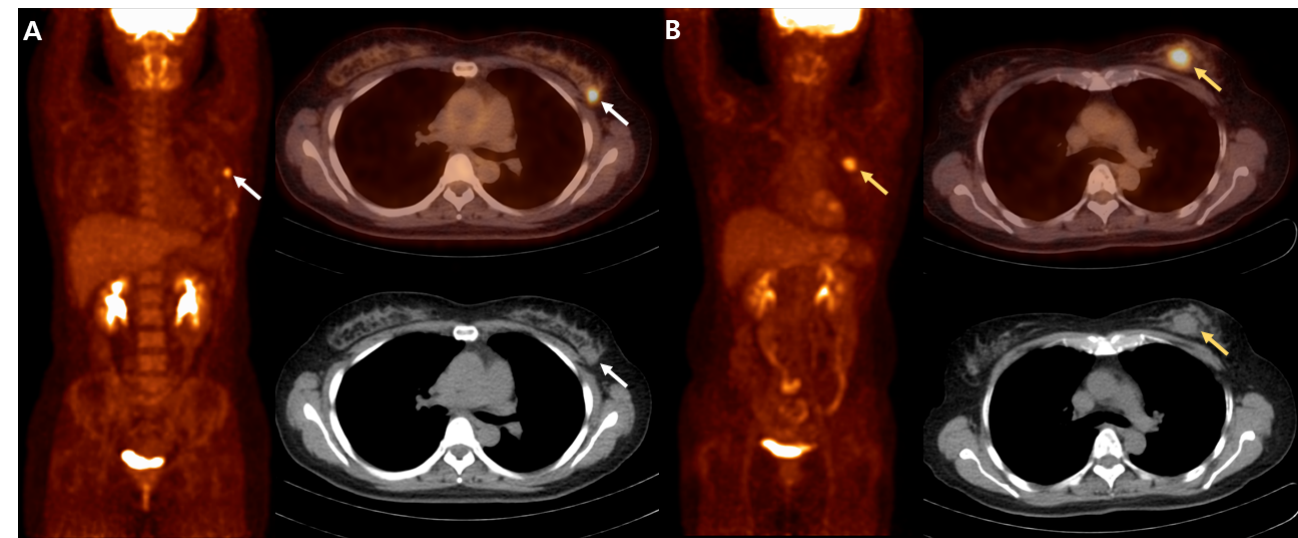
Figure 2. FDG PET/CT images in patients with early breast invasive ductal carcinoma. ( A ) A